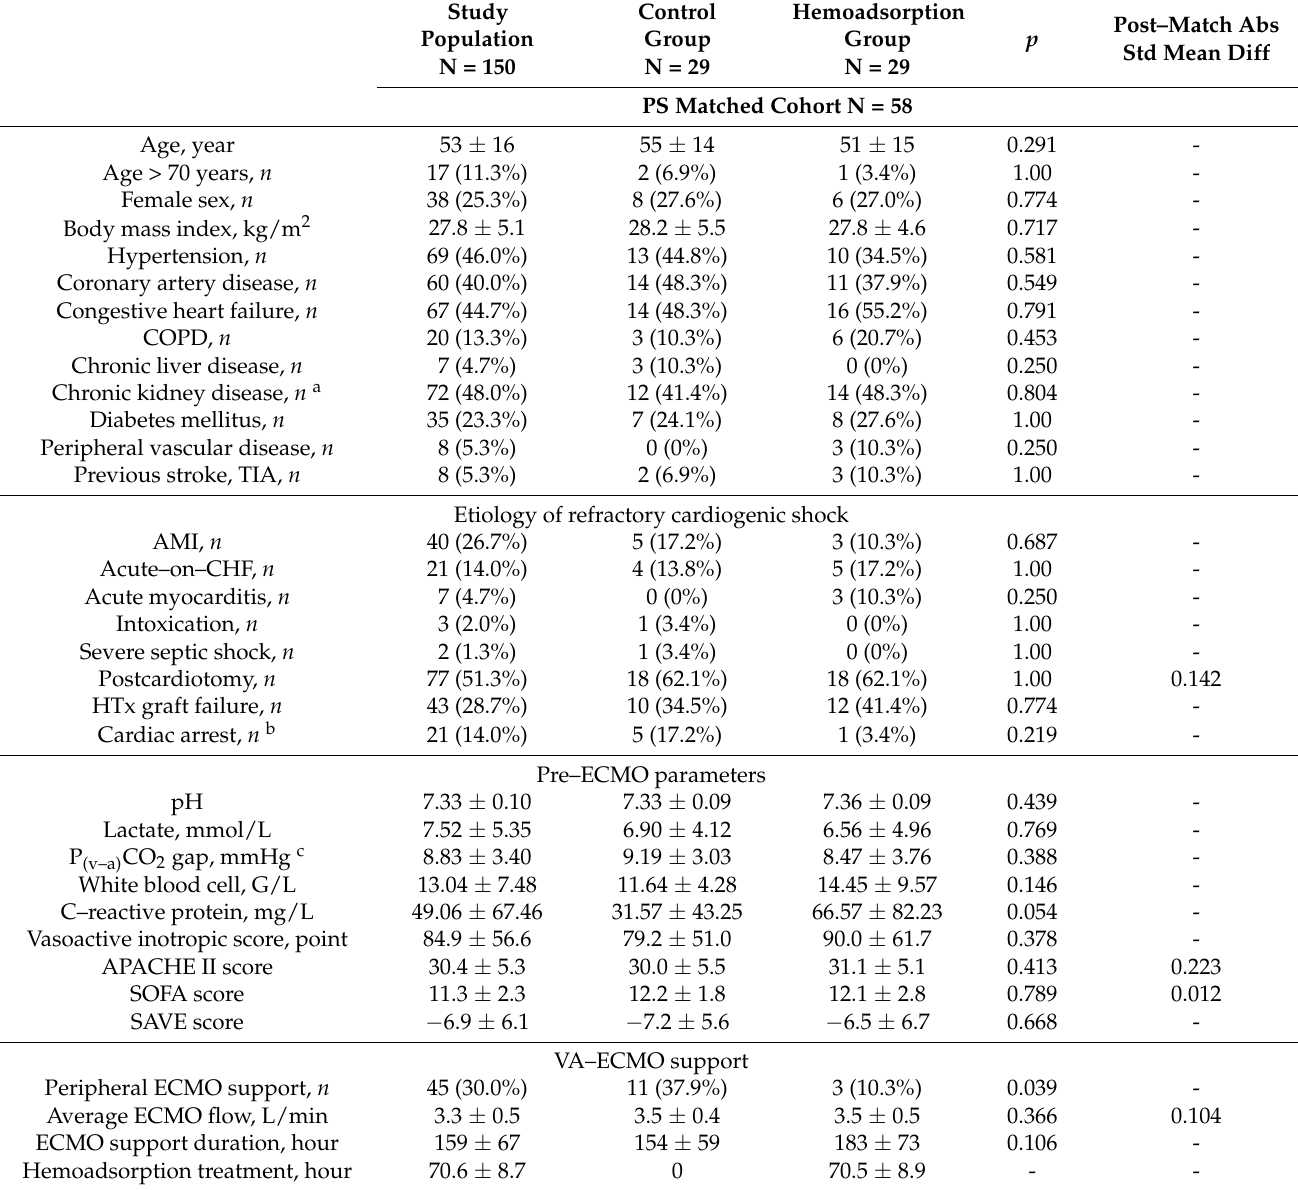
Table 1. Patient characteristics and clinical data in the unmatched and matched